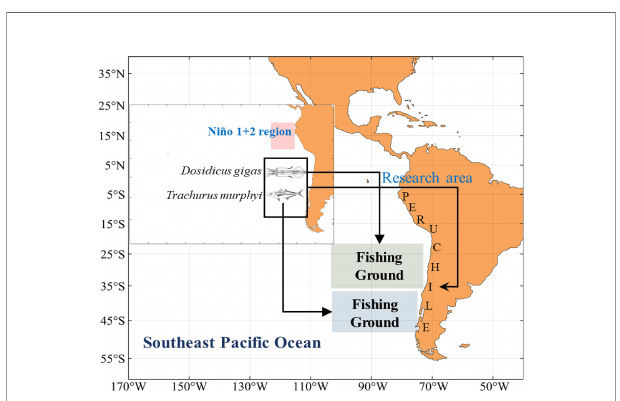
FIGURE 1 | Geographical distribution of fi shing ground of Dosidicus gigas and Trachurus murphyi off Chile and the Niño 1 + 2 region in the Eastern Paci fi